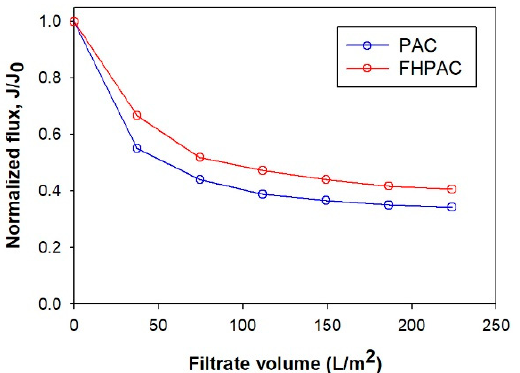
Figure 5. Flux decline in biofouling test under the PAC + UF and FHPAC + UF systems. J and J 0 denote filtrate fluxes at any filtrate volume and at the beginning of filtration, respectively.